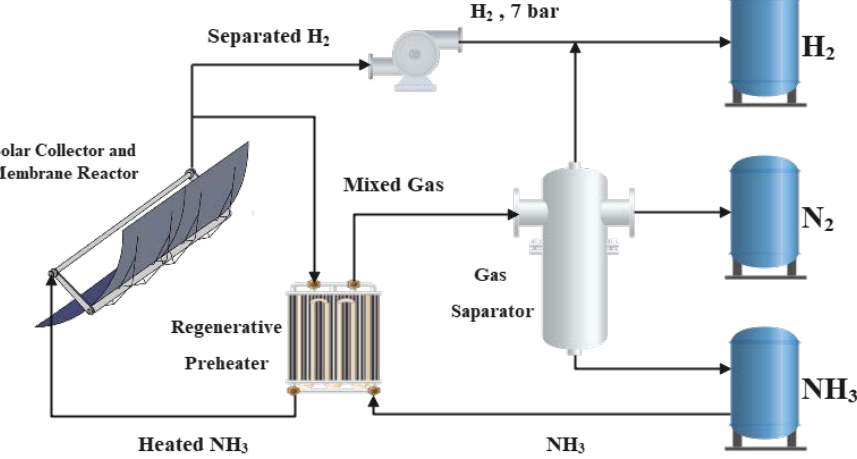
Figure 1. Schematic diagram of ammonia decomposition solar heat absorption system [25]. Reprinted/adapted with permission from Ref. [25]. 2022, Tianchao Xie.